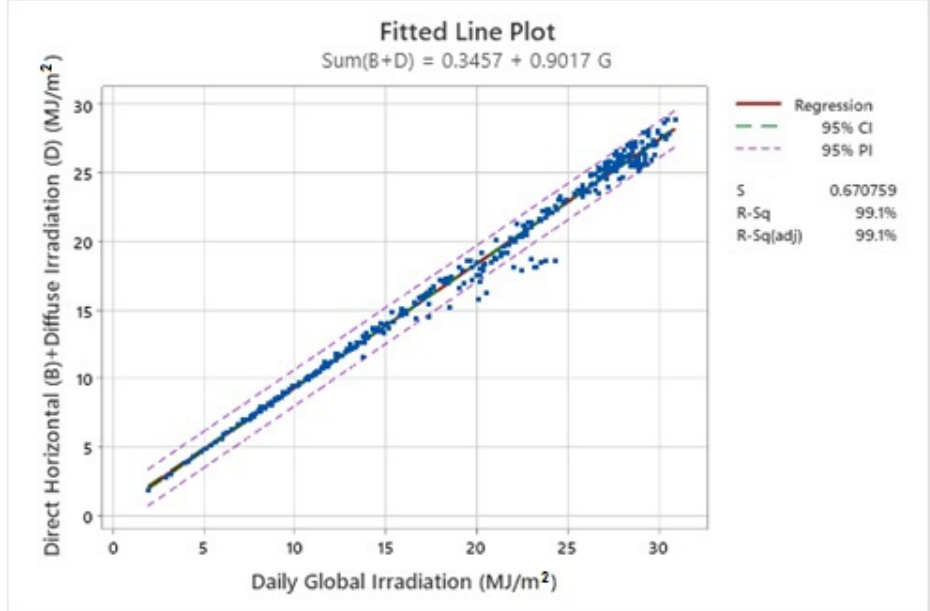
Figure 12. Linear regression between the sum ( B d + D d ) and global irradiation ( G d ). Figure 13 shows the linear relationship between the daily clearness index ( K T ) and the daily relative sunshine ( σ ). Most of the values are within the 95% prediction intervals. According to Scharmer and Greif [43], if the deviations of the pairs K T and σ from the regression line are greater than 0.3, then the pairs are considered as suspect. Generally, the deviations are lower than 0.3. Additionally, the daily sums of sunshine duration ( S d ) are lower than the astronomical daylength ( S 0 d ).